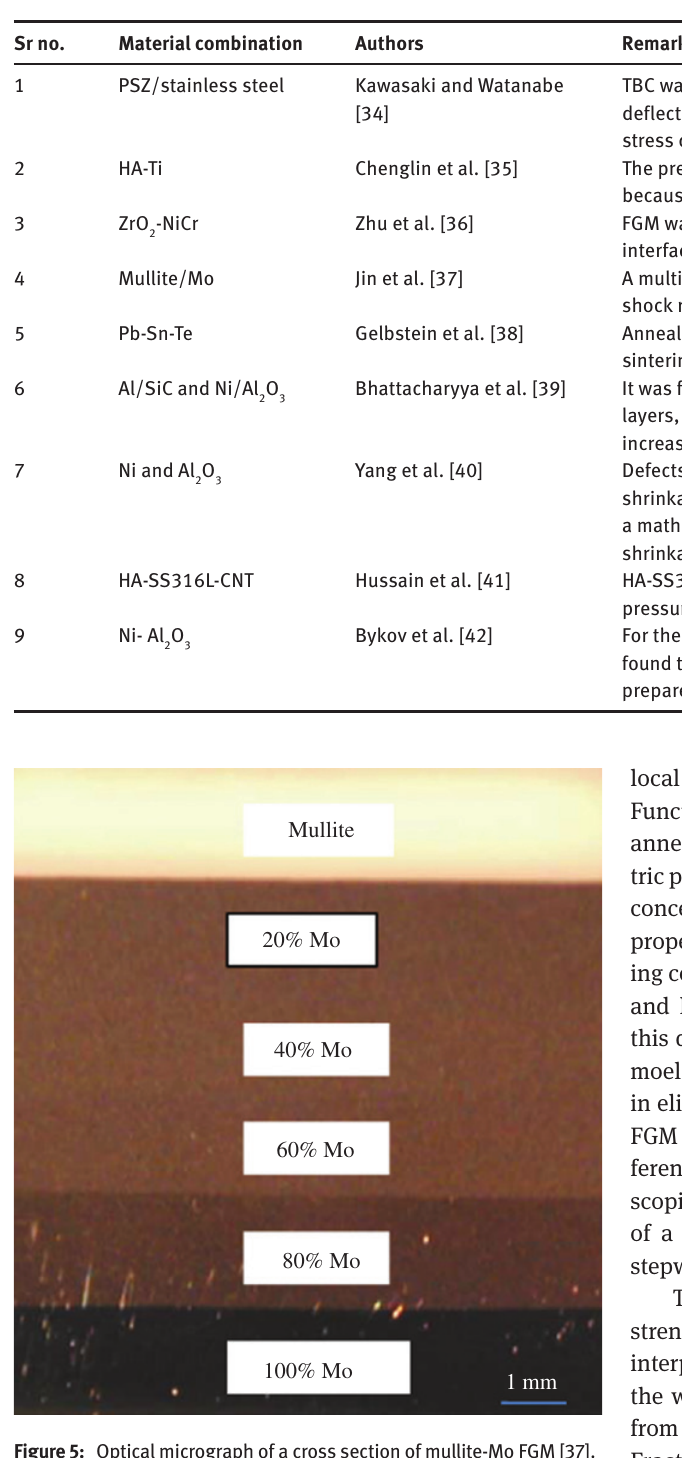
Figure 5: Optical micrograph of a cross section of mullite-Mo FGM [37].